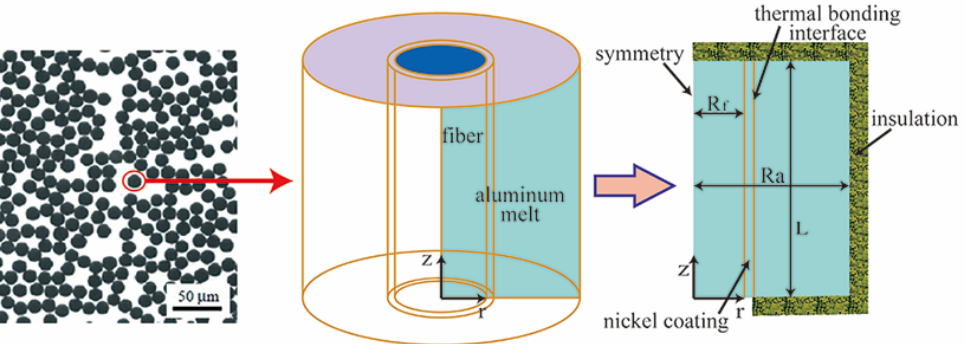
Figure 1. A schematic describing the 3D axisymmetric unit-cell for the carbon fiber/aluminum alloy MMC, as described in [17,30].